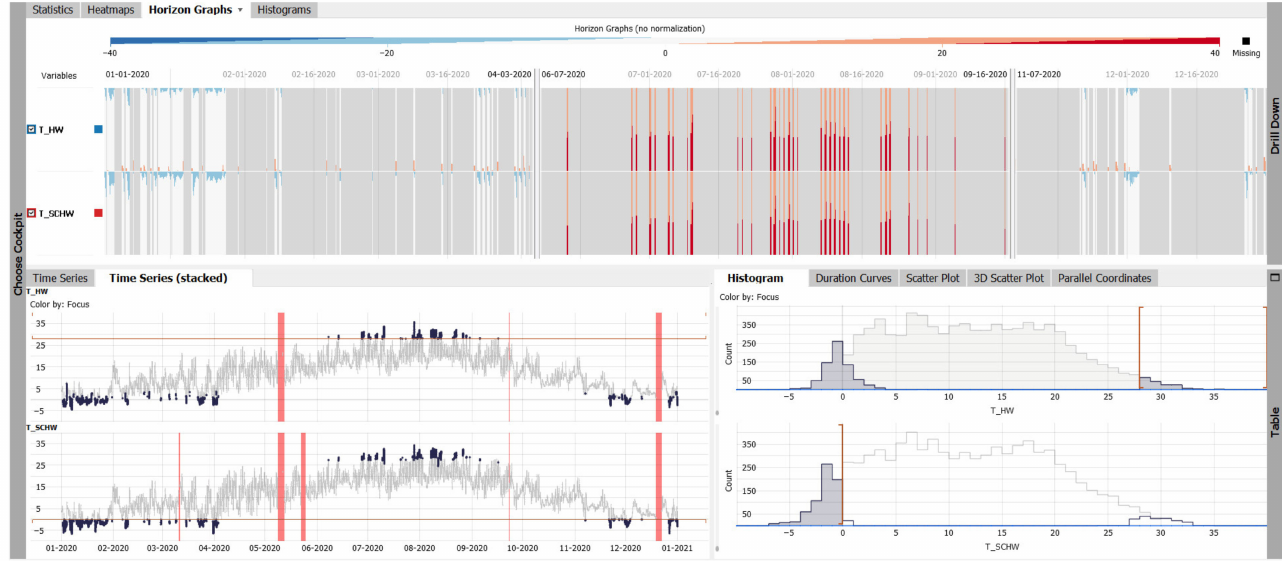
Figure 7. Comparative analysis of air temperature datasets originating from urban and rural environ- ments showing a clear misalignment of low and high temperature ranges, along the warming signal in urban data.